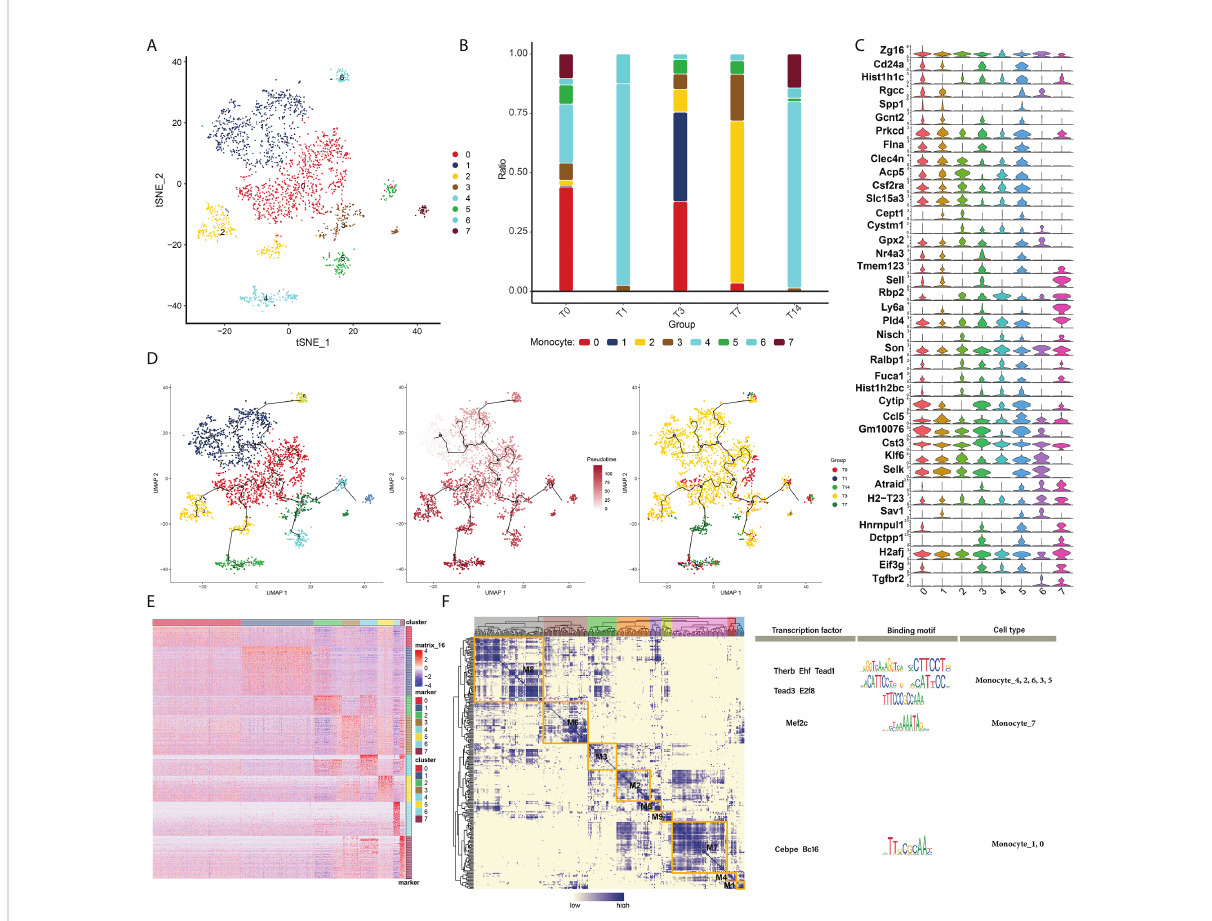
FIGURE 3 Changes in myeloid immune cells in RT-induced intestinal tissues. (A) Radiation reprograms the subset of myeloid immune cells. (B) Changes in the abundance of myeloid immune cells subsets. The colors of the different columns represent the changes in the immune cells at different times after radiotherapy. (C) Radiation reprograms the expression of marker genes in a subset of myeloid immune cells and monocytes. (D) Radiation reprograms the immune cell subsets of the myeloid lineage with increasing time after radiation exposure. (E) Expression of myeloid immune cell monocyte genes in different subgroups after radiation exposure. (F) Regulatory sub-module of myeloid immune cell monocyte subsets. Regulators of monocytes were divided into eight modules, and the motif of the regulator is shown on the